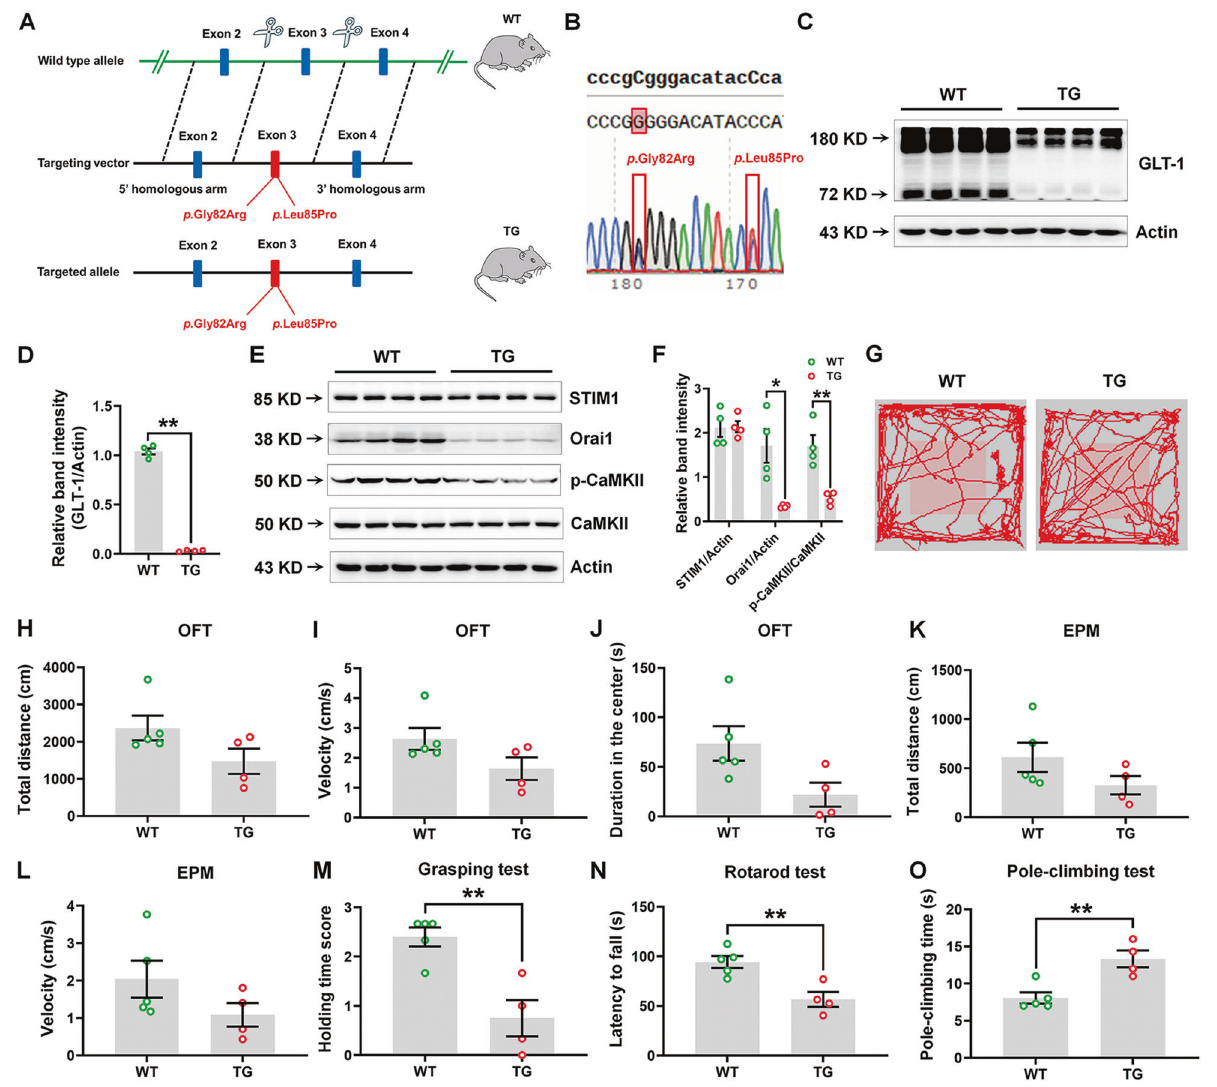
Fig. 6 Establishment of G82R/L85P variant knock-in mice. A , B Strategy of establishing the G82R/L85P variant knock-in mice. C , D Representative blots and quanti fi cation of GLT-1 in the hippocampus of WT and TG mice were determined by Western blot. n = 4 per group. E , F The representative blots and quanti fi cation of STIM1, Orai1, phosphorylation of CaMKII, and total CaMKII in the hippocampus of WT and TG mice were determined by Western blot. n = 4 per group. G The representative trace mice traveled in the open fi eld. The total traveled distance ( H ), movement speed ( I ) in the OFT, and duration in the center zone of open fi eld ( J ) are shown. K , L The total traveled distance and movement speed in the EPM test. M The grasping test was used to examine the grip strength of mice. N The rotarod test was used to examine the motor coordination of mice. O The pole-climbing test was used to examine bradykinesia in mice. n = 5 for WT mice (four males and one female) and n = 4 for TG mice (three males and one female). Results are expressed as mean ± SD. ** P < 0.01, ** P < 0.05 vs. WT. Statistical signi fi cance was determined using Student ’ s t